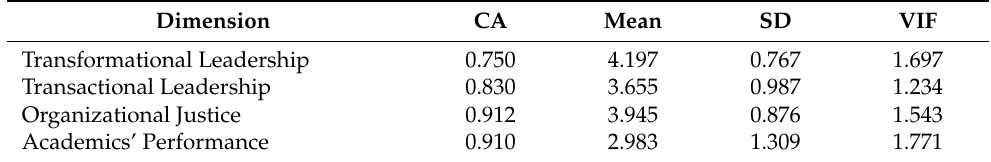
Table 3. VIF Values.